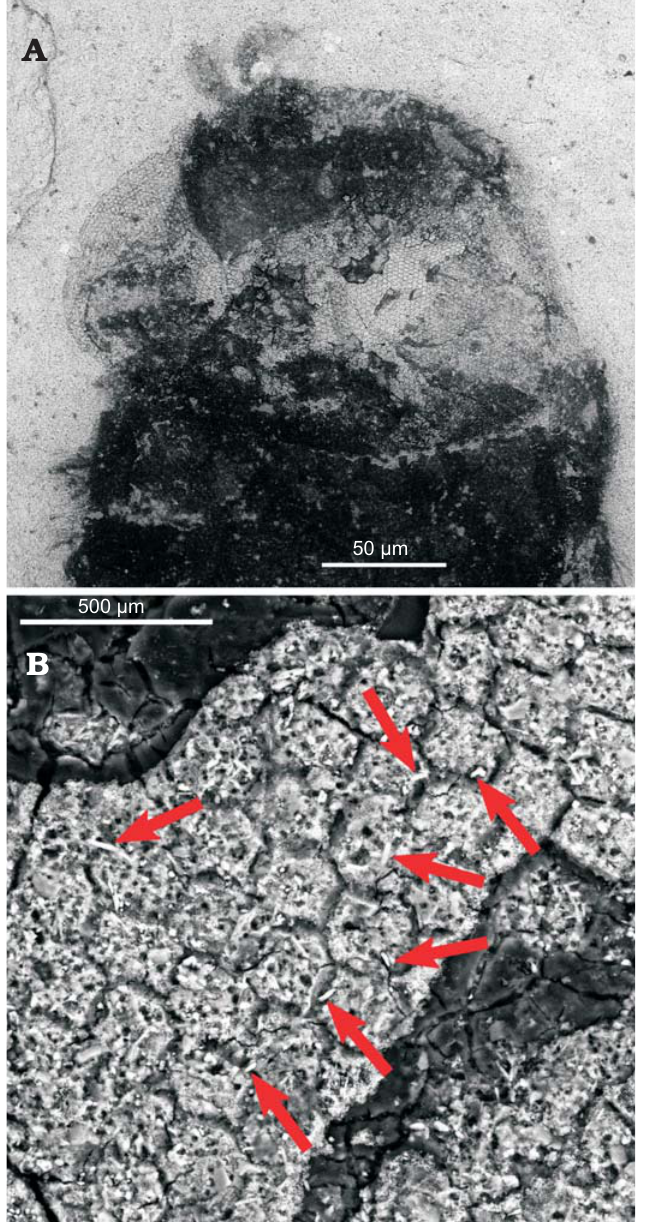
Fig. 3. Pipizine hoverfly Oligopipiza quadriguttata Nidergras, Hadrava, and Nel gen. et sp. nov., holotype RNGL-S01, Rupelian, Céreste, France.